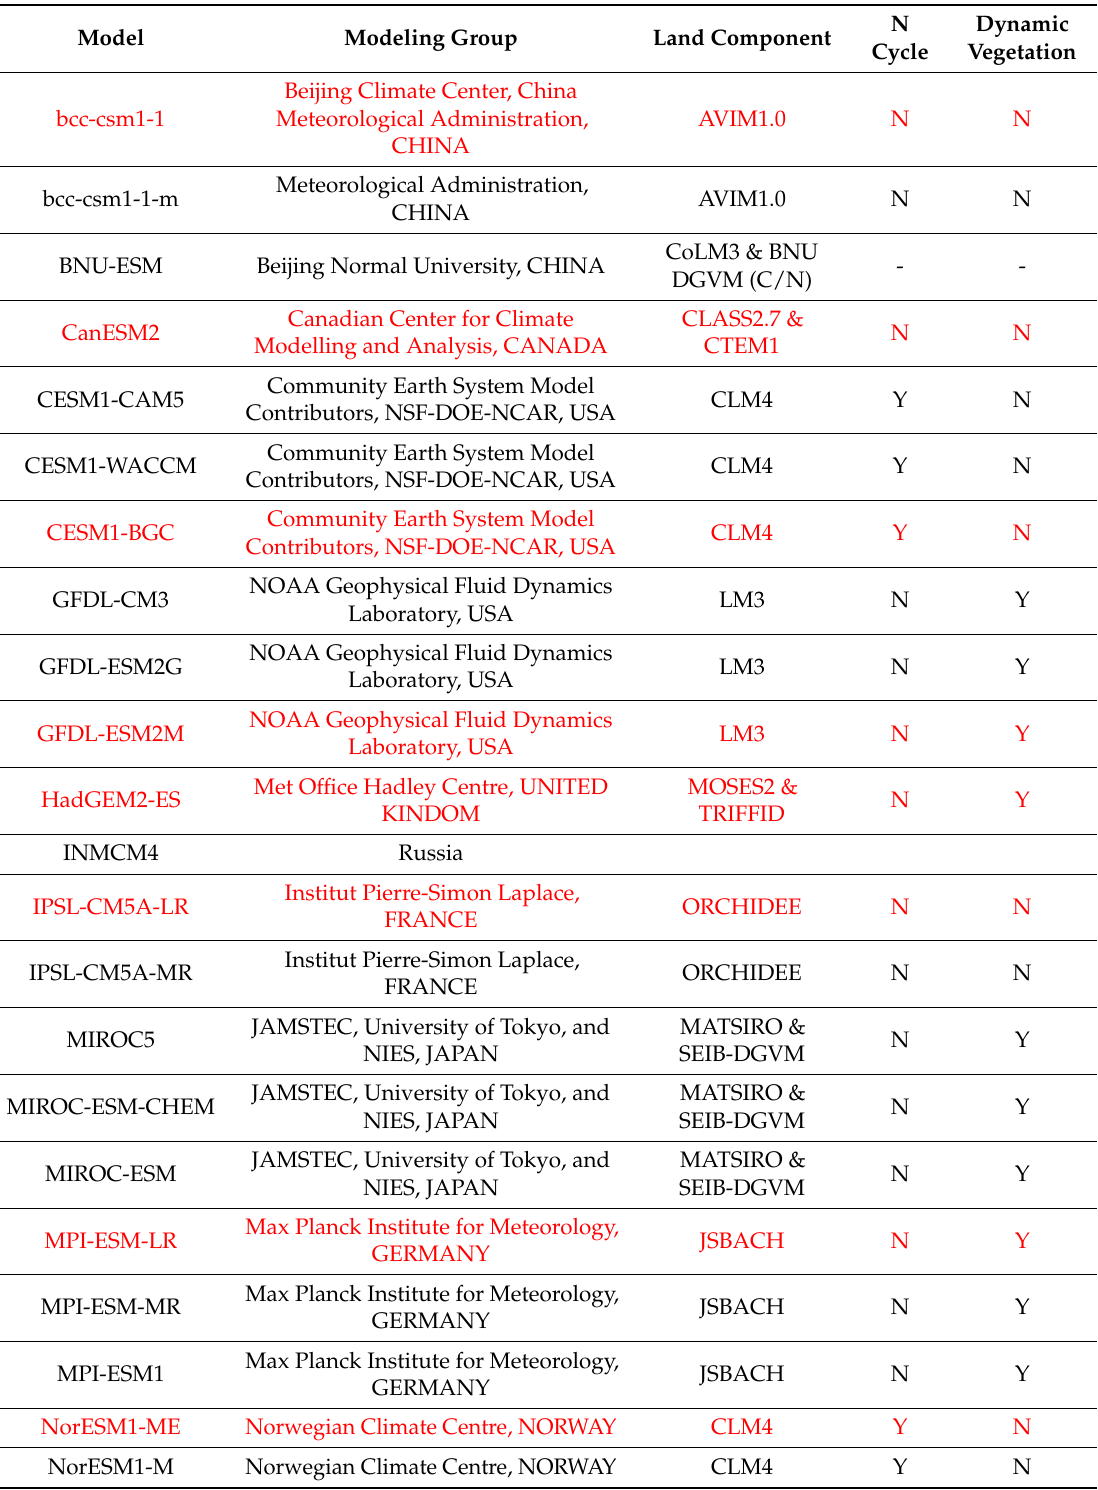
Table 1. Coupled Model Intercomparison Project Phase 5 (CMIP5) models and the forcing characteristics. Models used in the sensitivity analysis (experiment IDs are esmFixClim1, esmFdbk1, and 1pctCO2) shown in the analysis are highlighted in